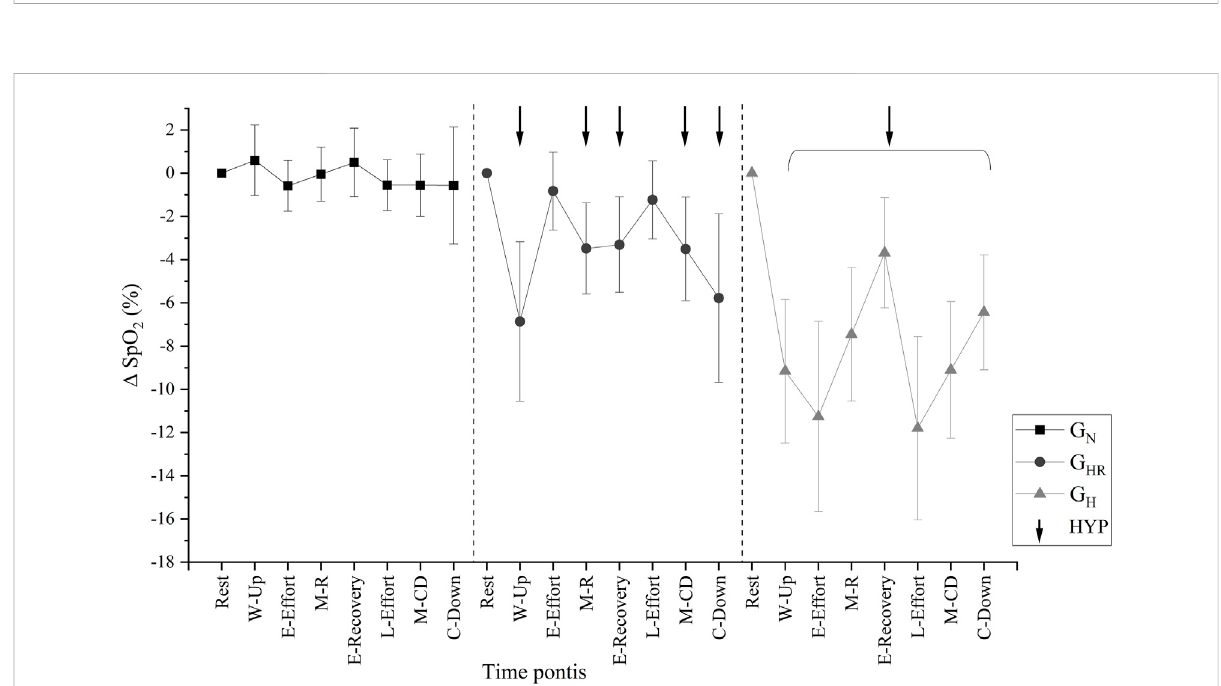
FIGURE 4 Average peripheral oxyhemoglobin saturation (SpO 2 ) by delta kinetics of each set measurement from the fi rst week of training. G N = group in normoxia; G HR = group in hypoxia recovery; G H = group in hypoxia; HYP = times in hypoxia. Rest = rest; W-Up = warm-up; E-Effort = end effort; M-R=meanvalueduringrecovery;E-Recovery=endrecovery;L-Effort=lasteffort;M-CD=averagebetween “ endoflasteffort ” and “ cool-down ” ; C-Down =